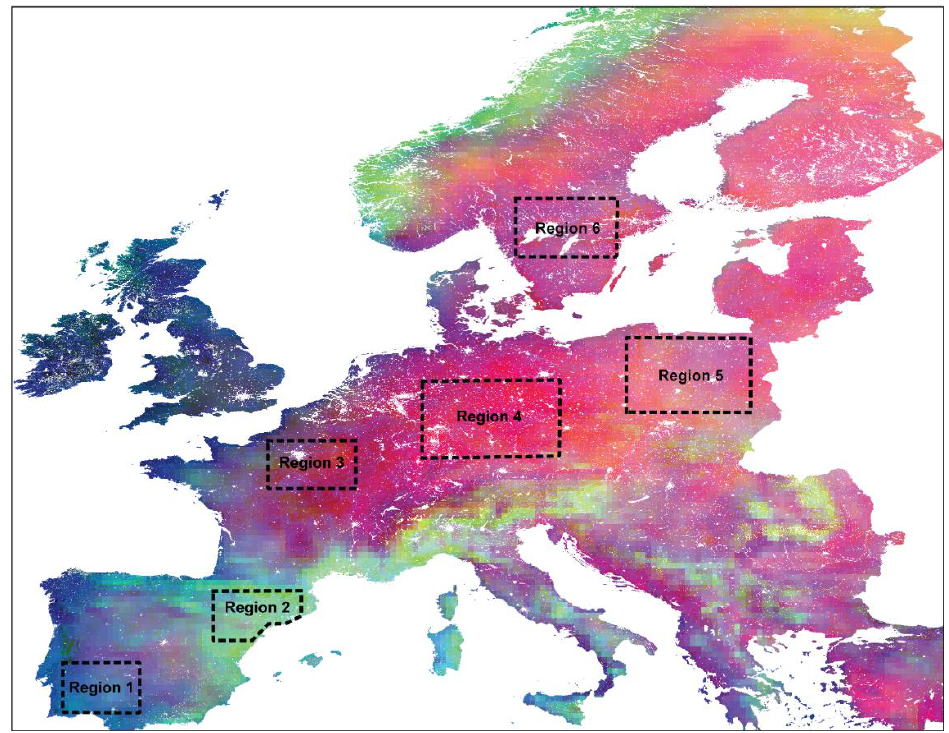
Figure 5. Comparative analysis of evapotranspiration (ET), surface air temperature (T sa ) and precipitation (P) anomaly pattern during the combined drought and heat wave in 2018. The black boundaries indicate contrasting regions of interest for further analysis. The base map is a false color composite, while Red-Green-Blue indicate absolute intensities of T sa , ET, and P, respectively. Table 2. Overview of drought characteristics for surface air temperature (T sa ), precipitation (P), and evapotranspiration (ET) for six selected regions distributed across Europe.